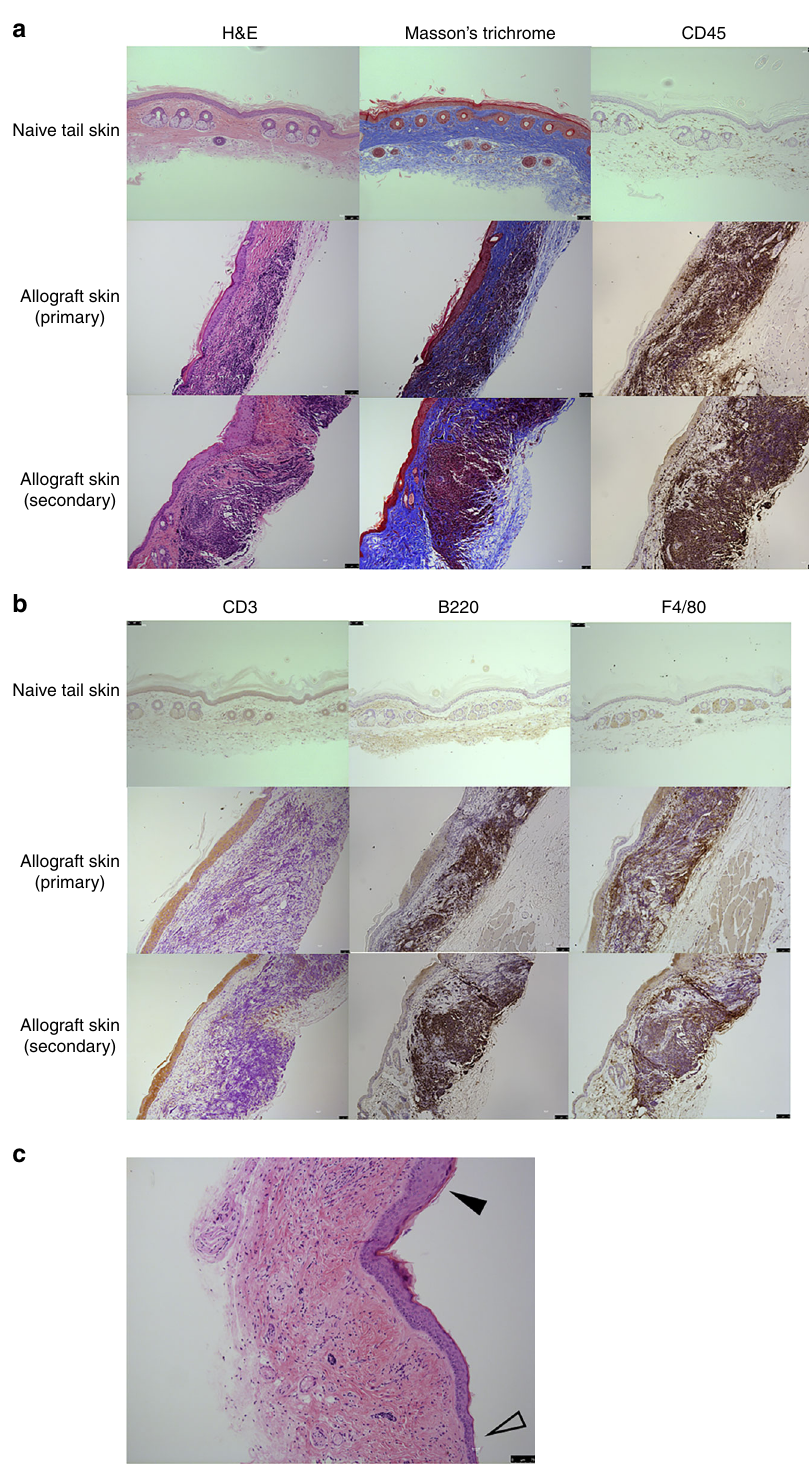
Fig. 3 Hematopoietic cell in fi ltration of surviving skin allografts in CD117-ADC-conditioned recipient mice. a , b Untransplanted (naive) BALB/c tail skin (upper panels) and both primary (middle panels) and secondary (lower panels) skin allografts from the indicated mouse strains were sectioned and stained as indicated in the fi gure with H&E, Masson ʼ s trichrome, and CD45 ( a ) or CD3, B220, and F4/80 ( b ). Data are representative of 11 mice from two independent experiments. c Immune cell in fi ltration of surviving skin allografts from CD117-ADC conditioned mice does not extend into adjacent recipient skin. Cell in fi ltration at the edge of skin allografts ( fi lled arrow head) and the surrounding recipient skin (open arrow head) is shown. Data are from H&E sections of skin and are representative of 11 mice from two independent experiments. Scale bars = 75 μ